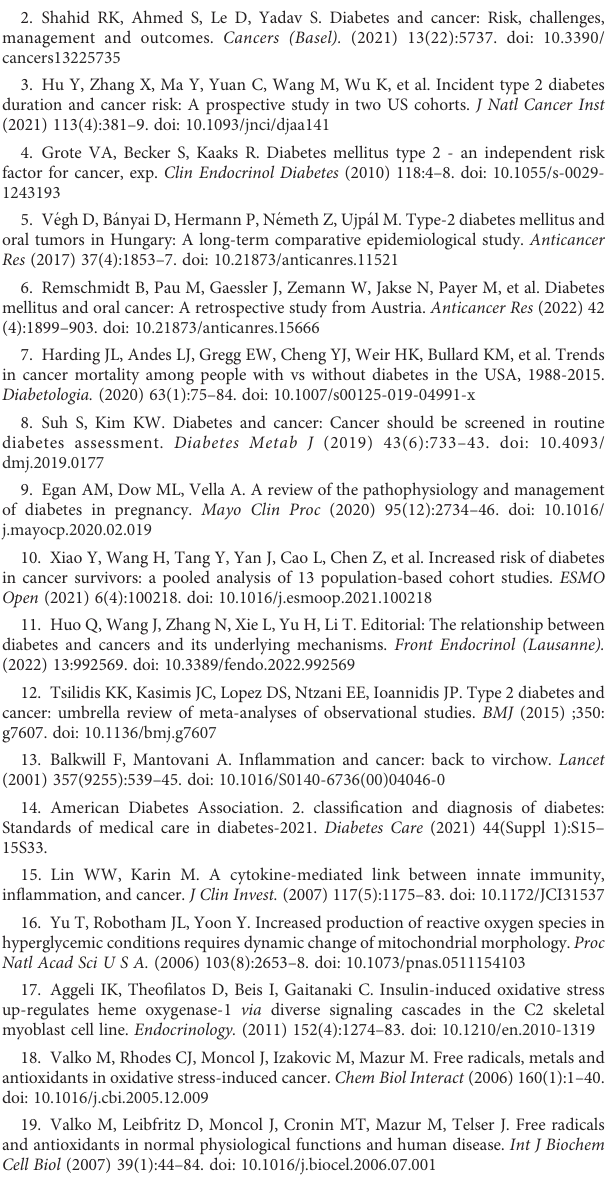
seven DCRGs and microsatellite instability (MSI) across cancers. (C) Correlations between expression of the seven DCRGs and the immunomodulators in COAD. SUPPLEMENTARY FIGURE 6 Drug response analysis. The correlation between drug sensitivity and the DCRGs across different cancers from the TCGA database. The scatter plots are ranked by p -values. SUPPLEMENTARY FIGURE 7 (A) Gene set variation analysis of metabolic pathway in macrophages between normal and adenoma tissues. (B) Gene set variation analysis of metabolic pathway in macrophages between normal and carcinoma tissues. (C) UMAP plot of the AUC score of each cell